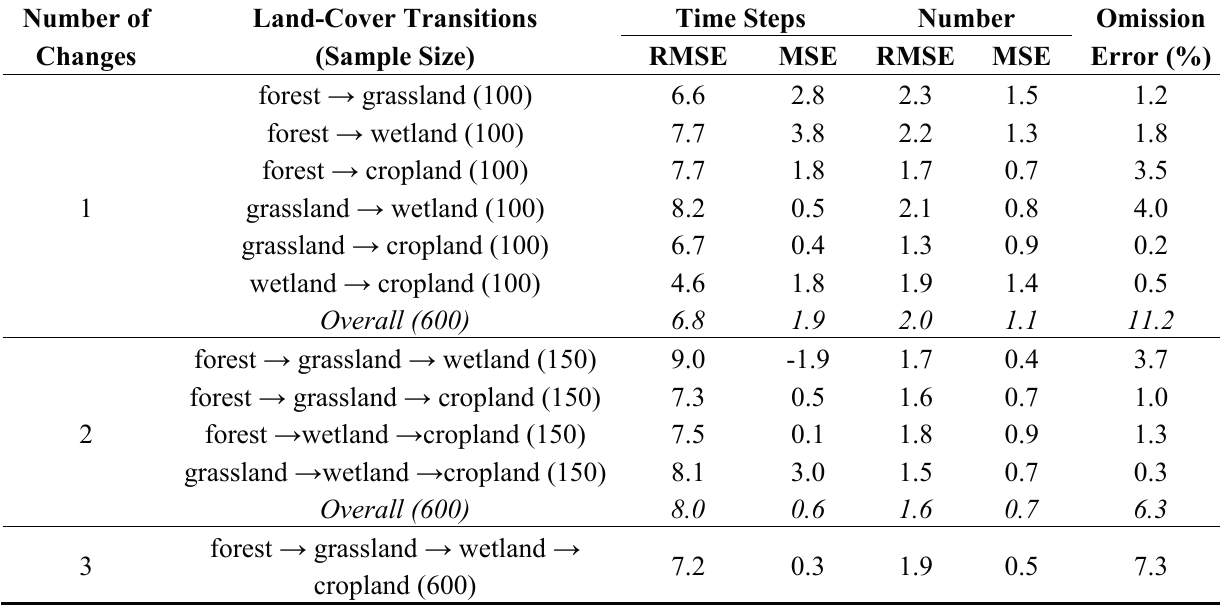
Table 3. Summary of the results for the simulated time series with